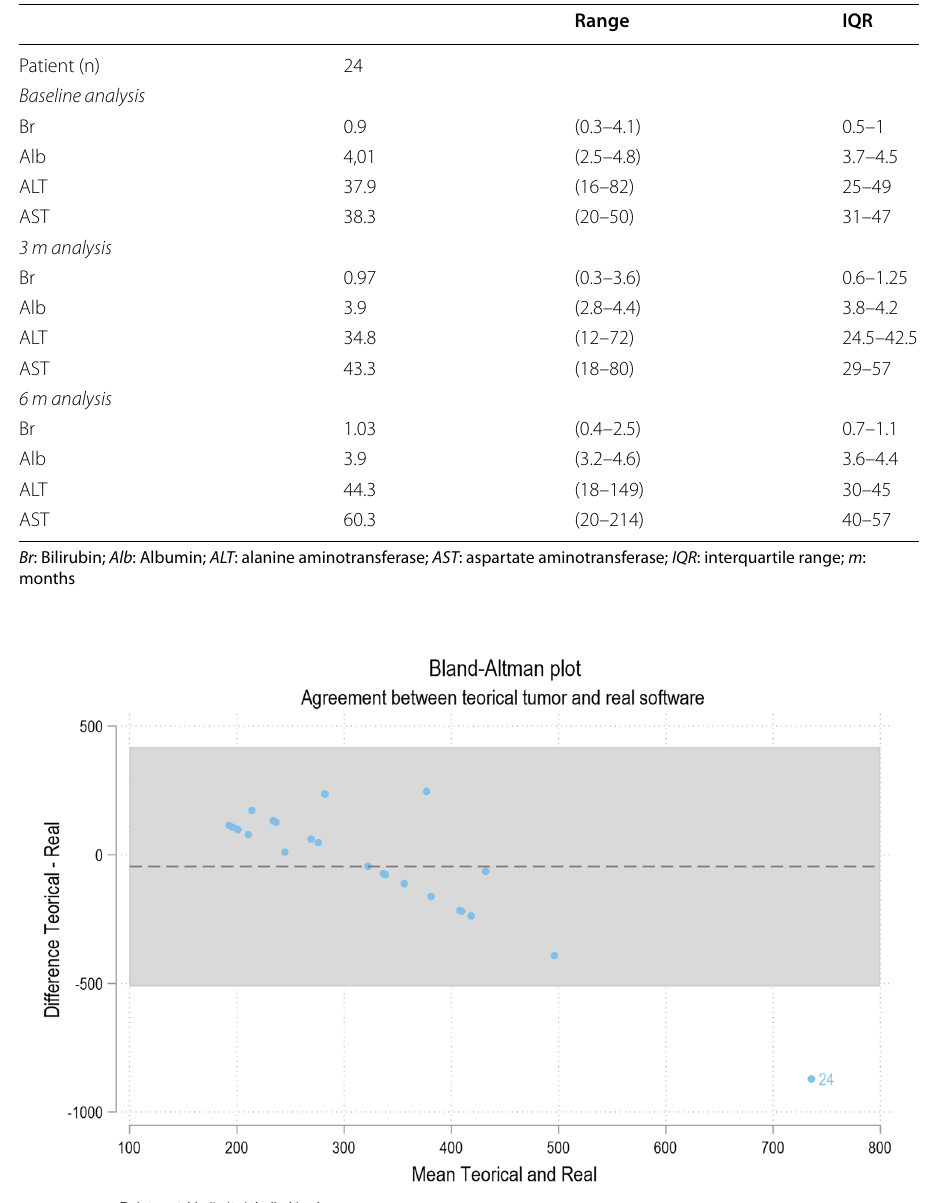
Table 3 Analytical values evolution